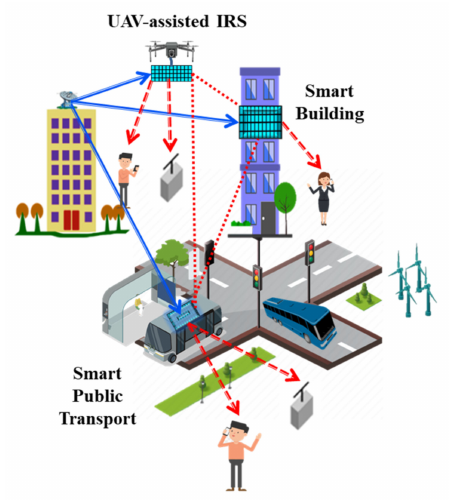
Figure 14. An overview of IRS-empowered UAV in smart cities (modified from